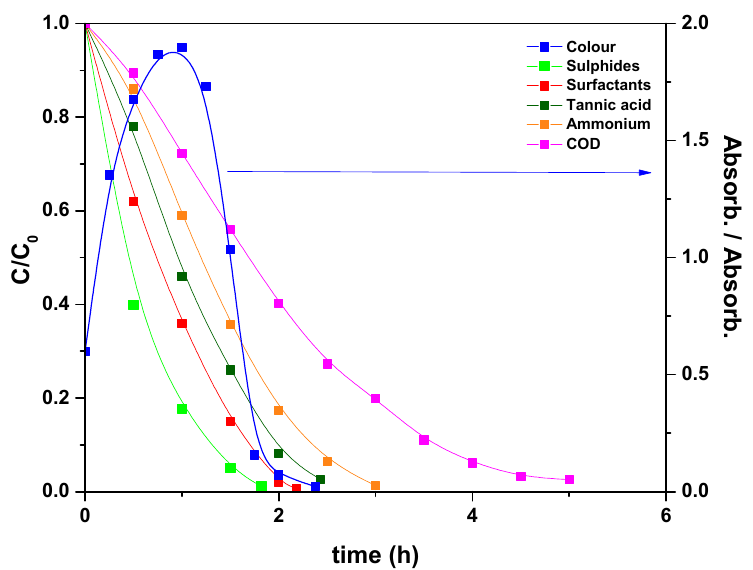
Figure 10. Evolution of the normalized concentrations and colour, expressed as a ratio between the absorbance at time t and the initial absorbance, during the electrolysis of a simulated real wastewater solution: T = 40 °C, pH = 10, applied current density of 600 A/m 2 .